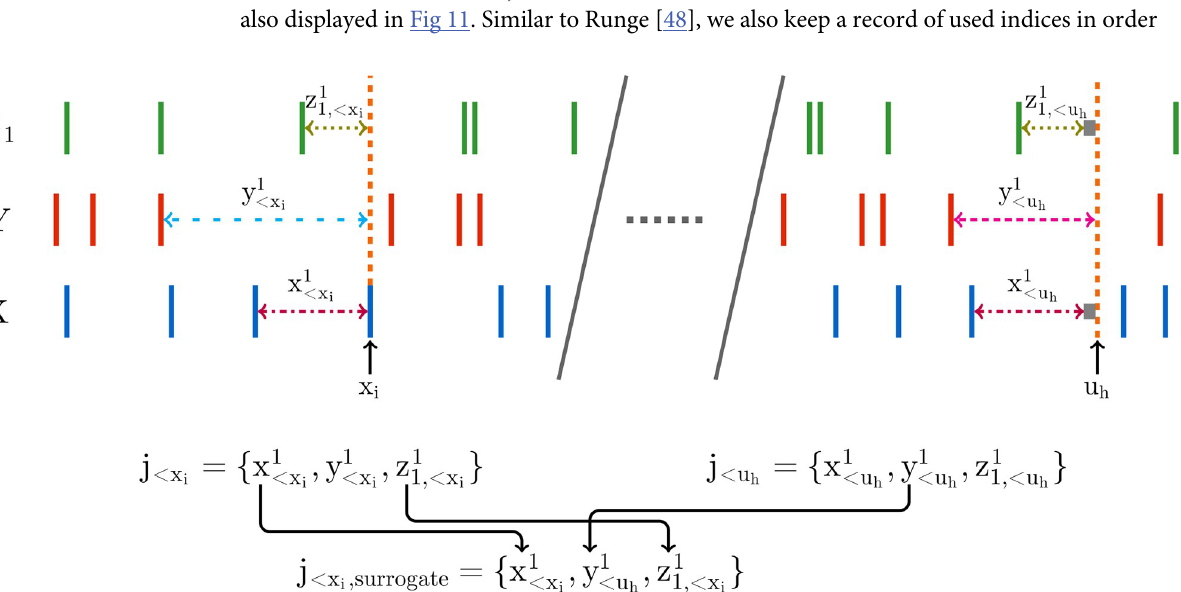
component of j < x i